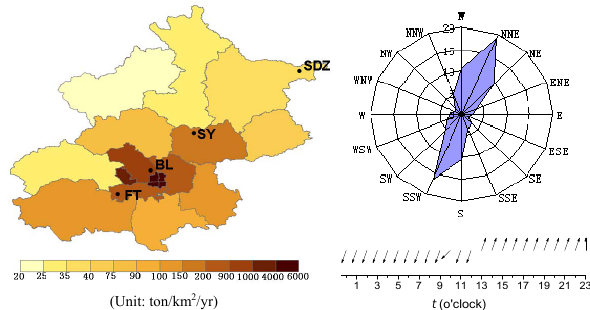
Fig.1. Sites location and CO emission density (Zhao et al., 2011) (left) and the wind direction 18 Fig. 1. Sites location and CO emission density (Zhao et al., 2011) rose with the diurnal variation of prevailing wind (right). (FT: FengTai; BL: BaoLian; SY: 19 ShunYi; SDZ: ShangDianZi) 20 (left) and the wind direction rose with the diurnal variation of pre- 21 vailing wind (right). (FT: FengTai; BL: BaoLian; SY: ShunYi; SDZ: ShangDianZi). Fig.2. Time series of hourly mean values of accumulative solar radiation, relative humidity 3